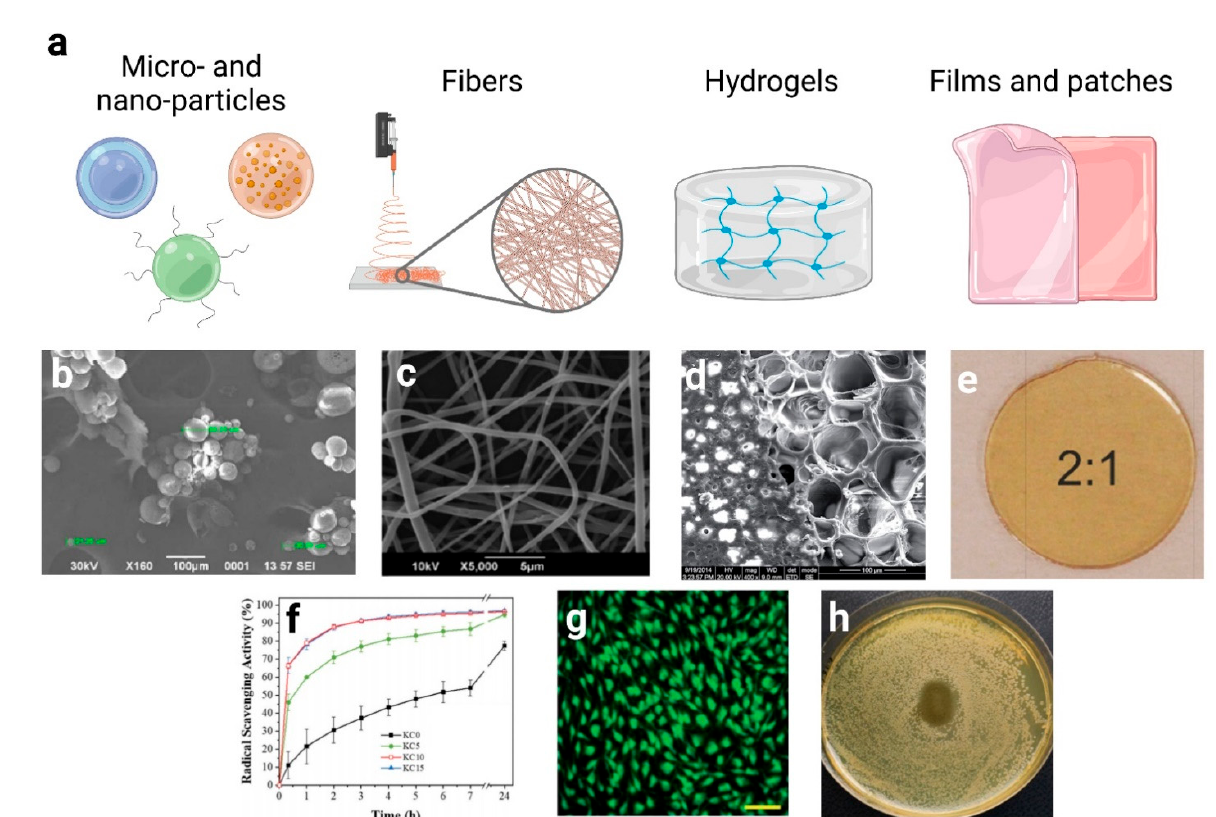
Figure 4. ( a ) Schematic representation of the principal nanocarriers exploited in the treatment of skin disorders created with BioRender.com (accessed on 15 May 2021). ( b ) SEM image of phyto-vesicles made of soy lecithin and